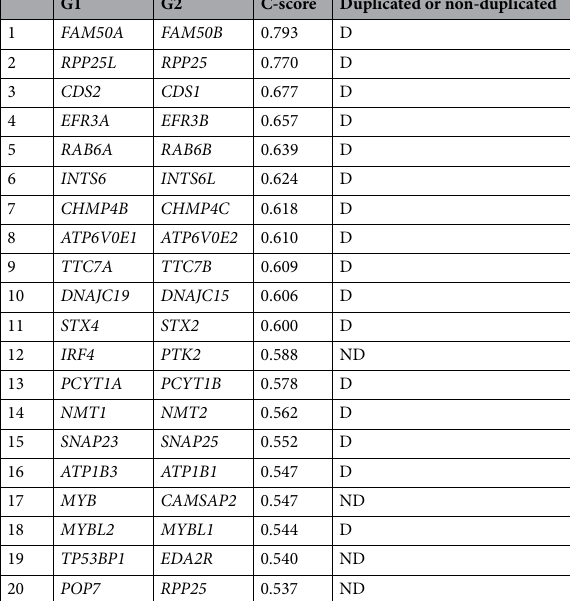
Table 1. Top 20 C-score gene pairs. The top 20 G1s pairing with the G2 that yields the highest C-score is shown. D duplicated gene pair, ND Non-duplicated gene